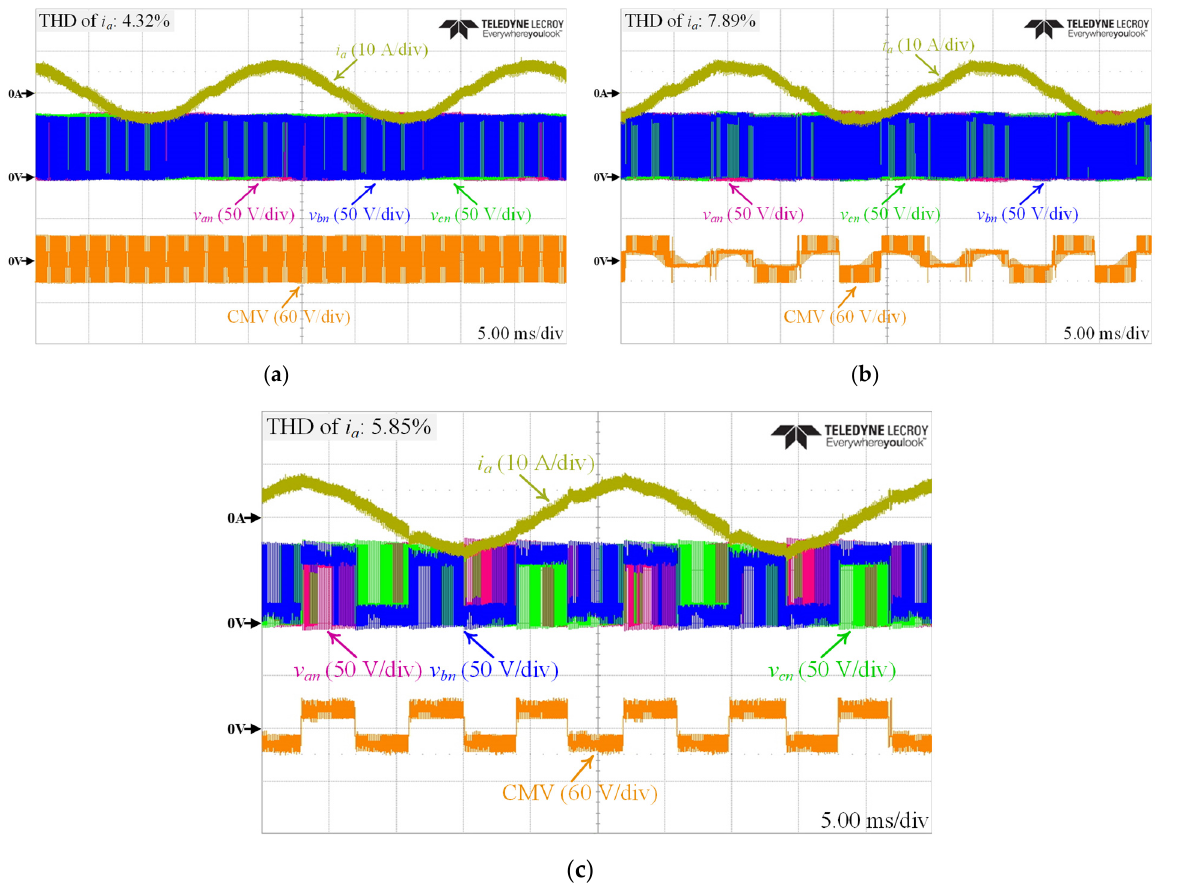
Figure 20. Comparison of experimental results of a -phase current, three-phase pole voltage, and CMV at rated load current and rotor speed of 500 rpm: ( a ) Standard SVPWM; ( b ) MRSPWM; ( c ) Proposed method.